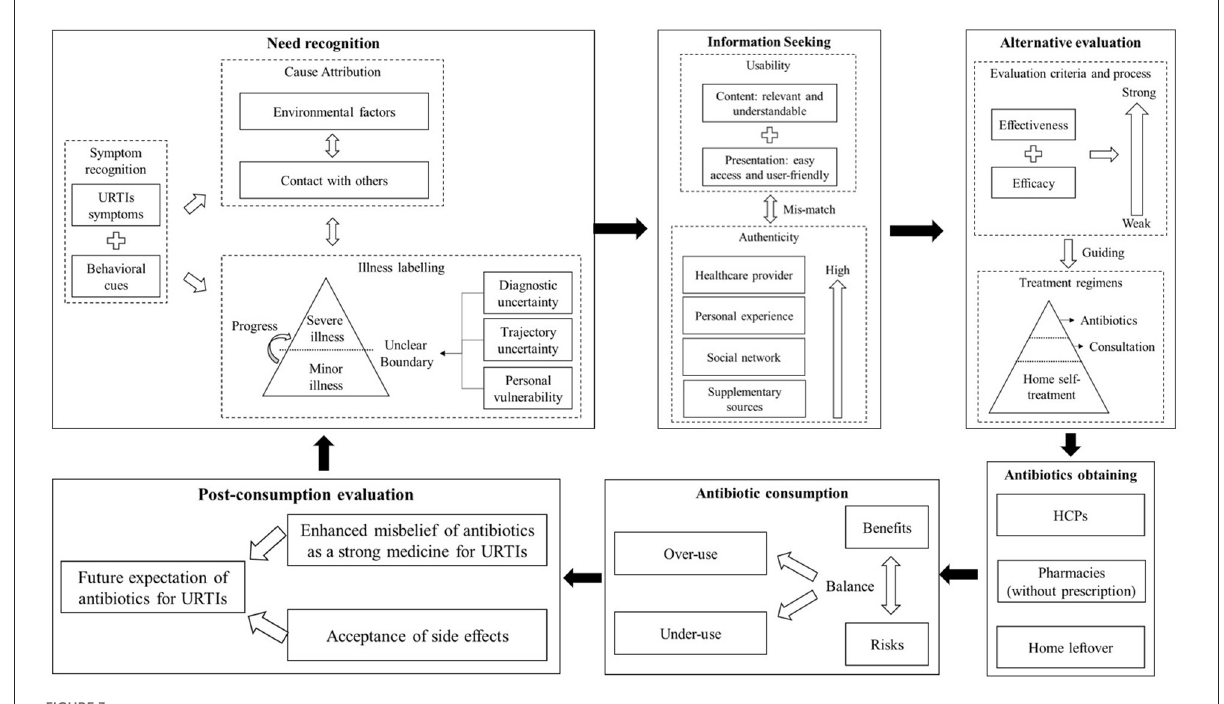
FIGURE3 Qualitative synthesis of the public’s antibiotic use for URTIs based on